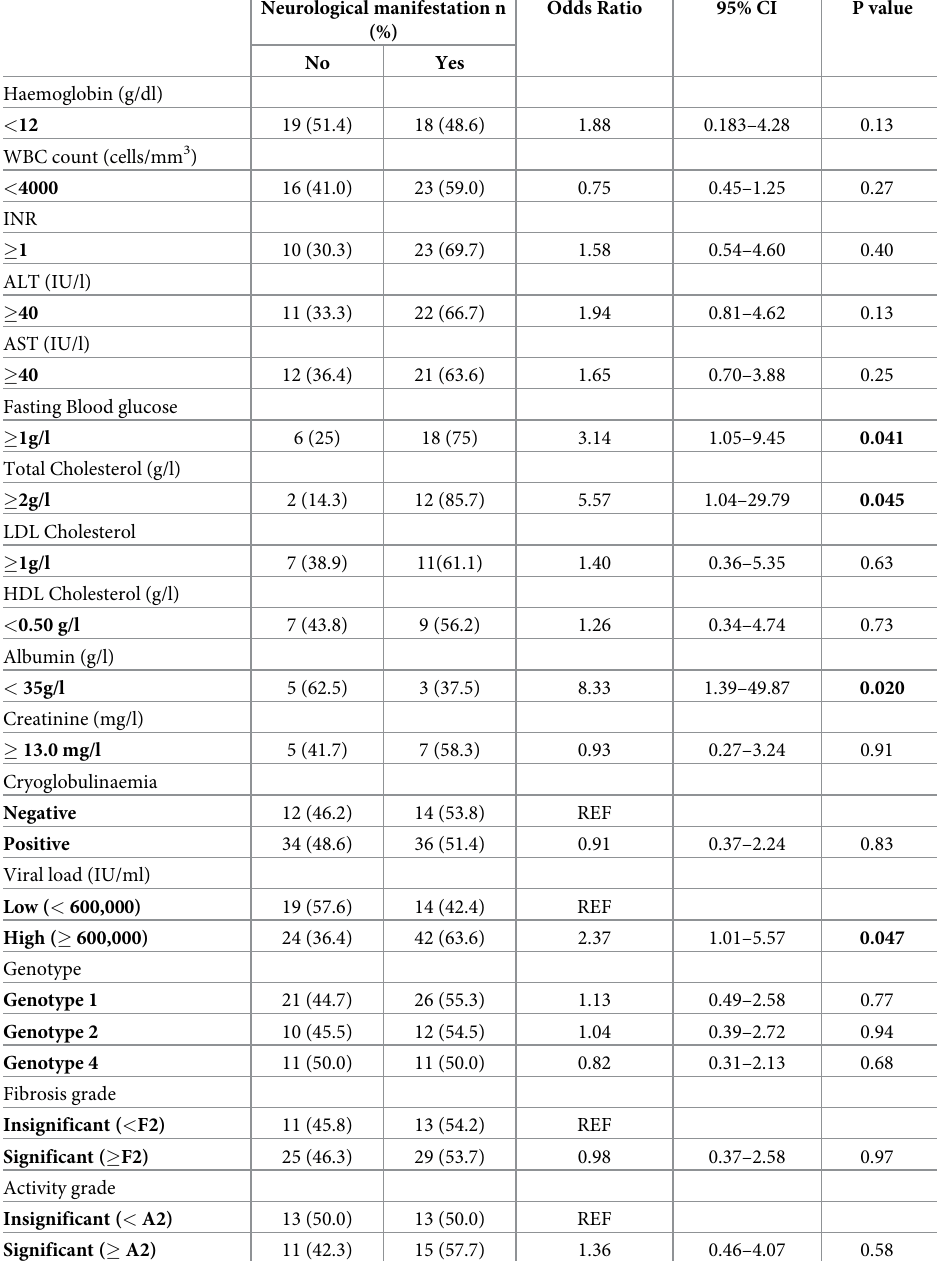
Table 8. Paraclinical factors associated with neurological manifestations in hepatitis C infected